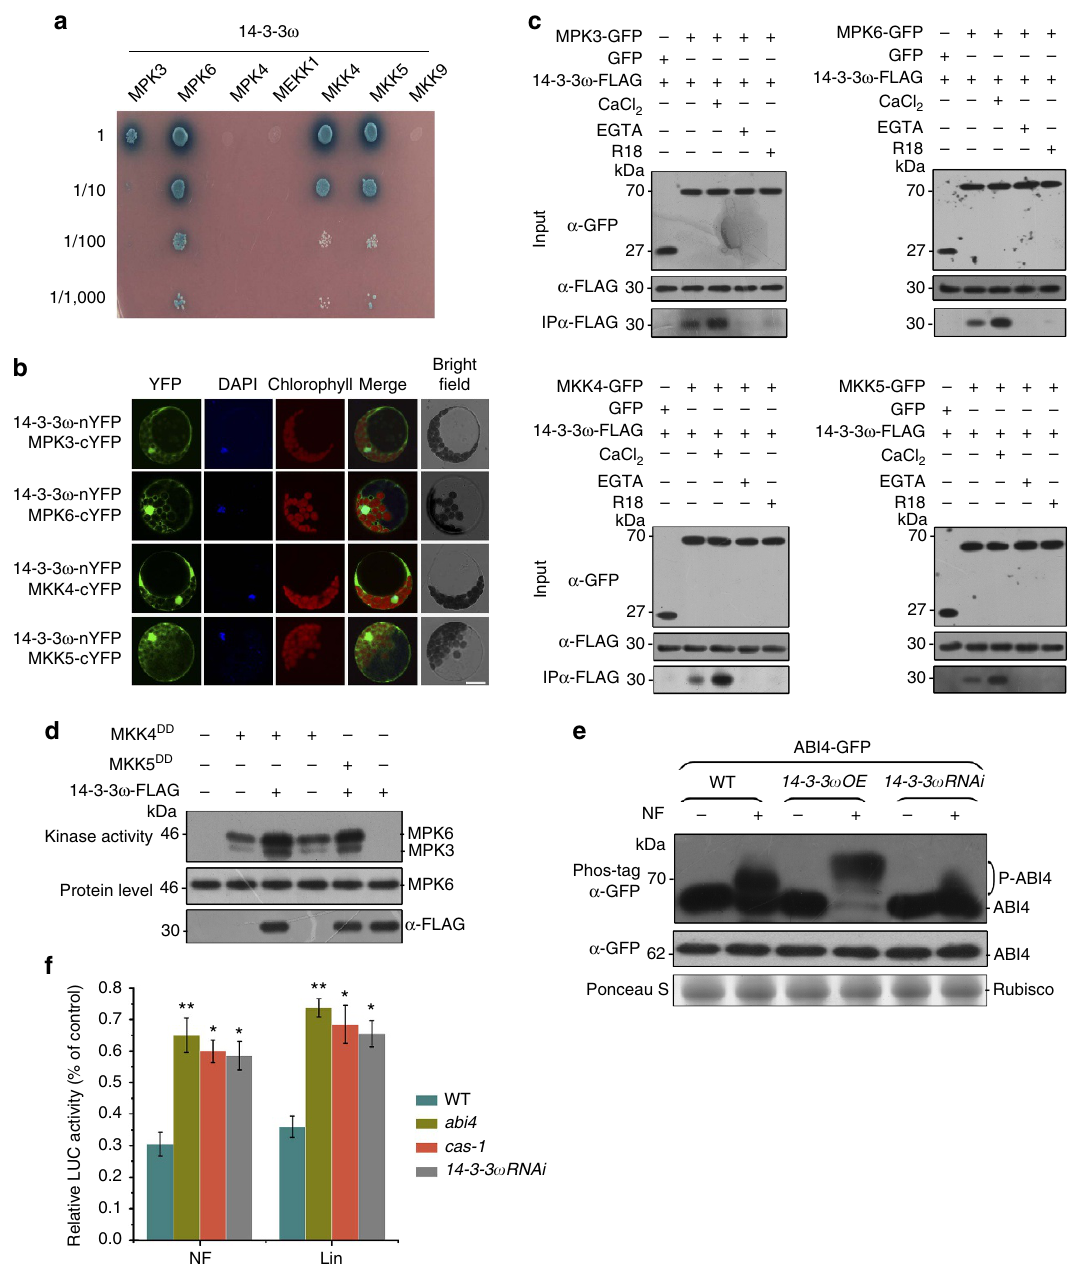
Figure 6 | 14-3-3 x facilitates MAPK activation through its Ca 2 þ -dependent scaffolding role that is essential for the retrograde response. ( a ) Yeast two-hybrid assay for the interaction of 14-3-3 o with MPK3/MPK6 and MKK4/MKK5. These strains were grown on synthetic dropout medium lacking Leu, Trp and His (SD-Leu-Trp–His) containing 40 m gml (cid:2) 1 X- a -gal (5-bromo-4-chloro-3-indolyl- a - D -galactopyranoside). ( b ) BiFC analyses for the interaction of 14-3-3 o with MPK3/MPK6 and MKK4/MKK5 in Arabidopsis protoplasts. YFP fluorescence was detected and the positions of nuclei were shown by 4, 6-diamidino-2-phenylindole (DAPI) staining. Scale bar, 10 m m. ( c ) Co-immunoprecipitation(co-IP) assays for the interaction of 14-3-3 o with MPK3/MPK6 and MKK4/MKK5. Protoplasts co-transfected with the MPK3/MPK6-GFP or MKK4/MKK5-GFP construct and the 14-3-3 o -FLAG construct were treated with 1mM CaCl 2 , 5mM EGTA or 10 m gml (cid:2) 1 R18 for 1h, and total protein extracts were subjected to immunoprecipitation. ( d ) Effect of 14-3-3 o on MAPK activation triggered by MKK4 DD or MKK5 DD . Protoplasts were transfected with MKK4 DD or MKK5 DD in the presence or absence of 14-3-3 o -FLAG constructs, and total protein extracts were subjected to immunoblot analysis with phosphor-p44/42 MAPK (Erk1/2) antibody. Equal loading was verified by immunoblot analysis with an anti-MPK6 antibody. ( e ) Phosphorylation status of ABI4 in wild-type, 14-3-3 o OE and 14-3-3 o RNAi plants expressing 35S:ABI4-GFP after NF treatment. Protein extracts from ABI4OE , ABI4 W T /14-3-3 o OE and ABI4 WT /14-3-3 o RNAi seedlings at 0.5h after NF treatment were separated by Phos-tag SDS–PAGE followed by immunoblot analysis with anti-GFP antibody (top). Another immunoblot analysis was done at the same time to detect the ABI4 protein (middle). Ponceau S staining was used to demonstrate equal loading (bottom). ( f ) Effect of NF and Lin treatments on the relative activity of the LUC reporter in protoplasts. Protoplasts isolated from wild-type, abi4 , 14-3-3 o RNAi and cas-1 mutant seedlings were cotransformed with both LHCB p:LUC and 35S:GUS constructs. Relative LUC activities after treatments are the ratio of LUC to GUS (internal control) normalized to the value of control (without treatment). Data represent means ± s.d. from five biological replicates. Asterisks indicate significant differences from the value of wild-type at * P o 0.05 or ** P o 0.01 using Student’s t test. NATURE COMMUNICATIONS|7:12173|DOI: